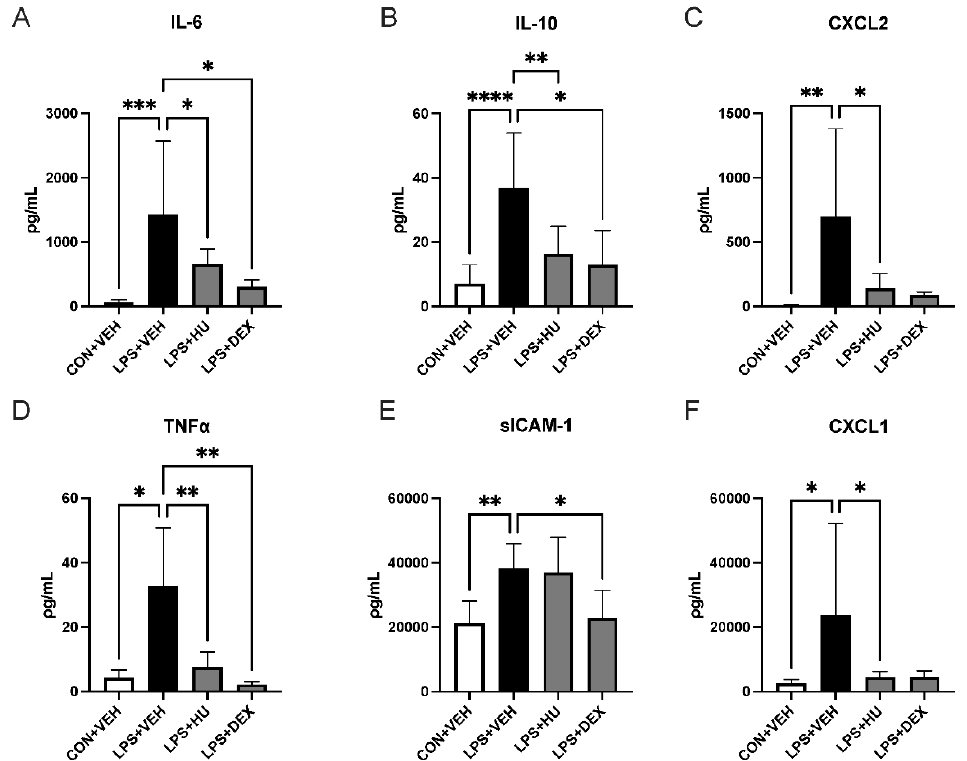
Figure 3. Impact of treatment on ALI-induced systemic cytokine release. Plasma levels of ( A ) IL-6, ( B ) IL-10, ( C ) CXCL2, ( D ) TNF α , ( E ) sICAM-1, and ( F ) CXCL1 were reduced following administration of HU-308 or DEX. Data are expressed as mean ± SD. Statistically significant differences were determined via one-way ANOVA with Dunnett’s multiple comparisons test and are depicted as * p ≤ 0.05, ** p ≤ 0.01, *** p ≤ 0.001, **** p ≤ 0.0001.